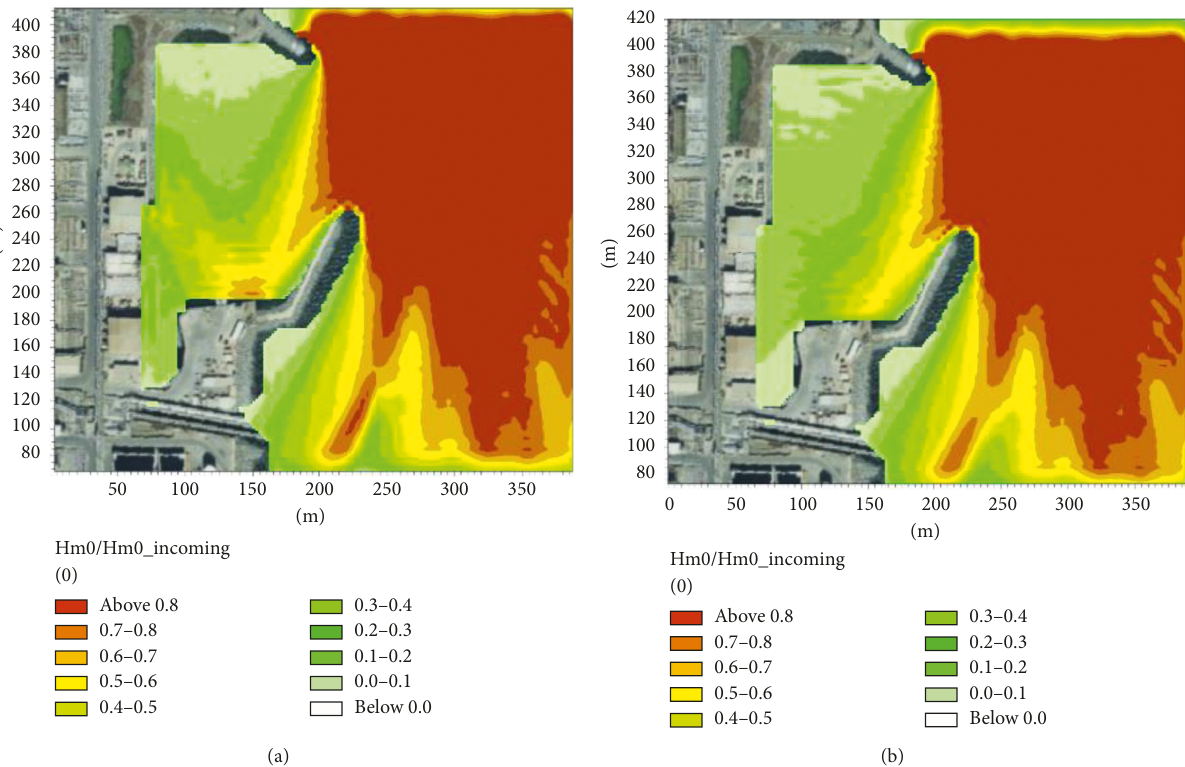
Figure 10: Wave disturbance coefficient for MWD � 0 ° N, T configuration with dentated structures